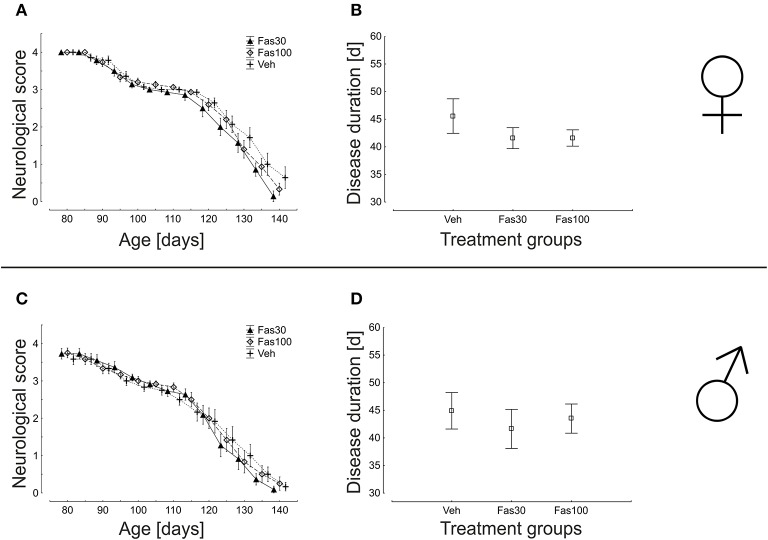
Progression of neurological symptoms and disease duration in SOD1G93A mice treated with 30 mg/kg Fasudil (Fas30), 100 mg/kg Fasudil (Fas100), or with vehicle (Veh) as control. Displayed are neurological scores and disease duration for female (Fas30 n = 14, Fas100 n = 15, Veh n = 14) (A,B) and male (Fas30 n = 11, Fas100 n = 12, Veh n = 12) (C,D) cohorts.